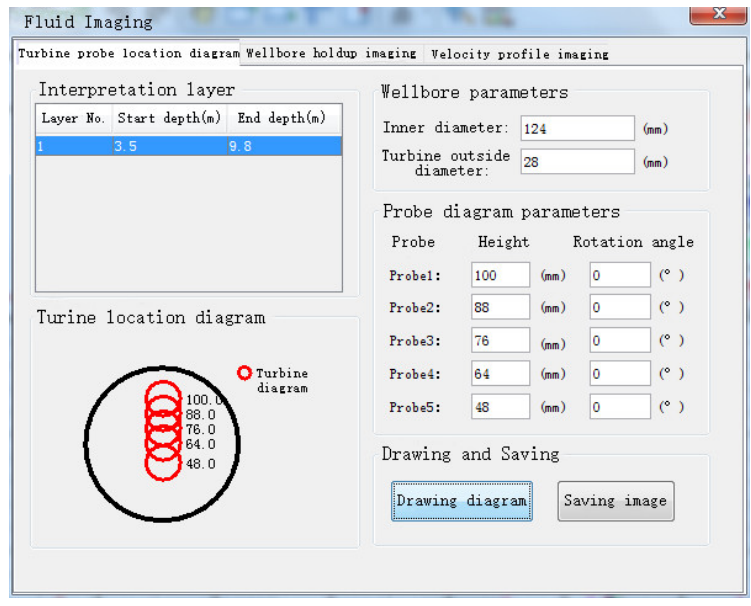
Figure 5. Diagram of measurement points.